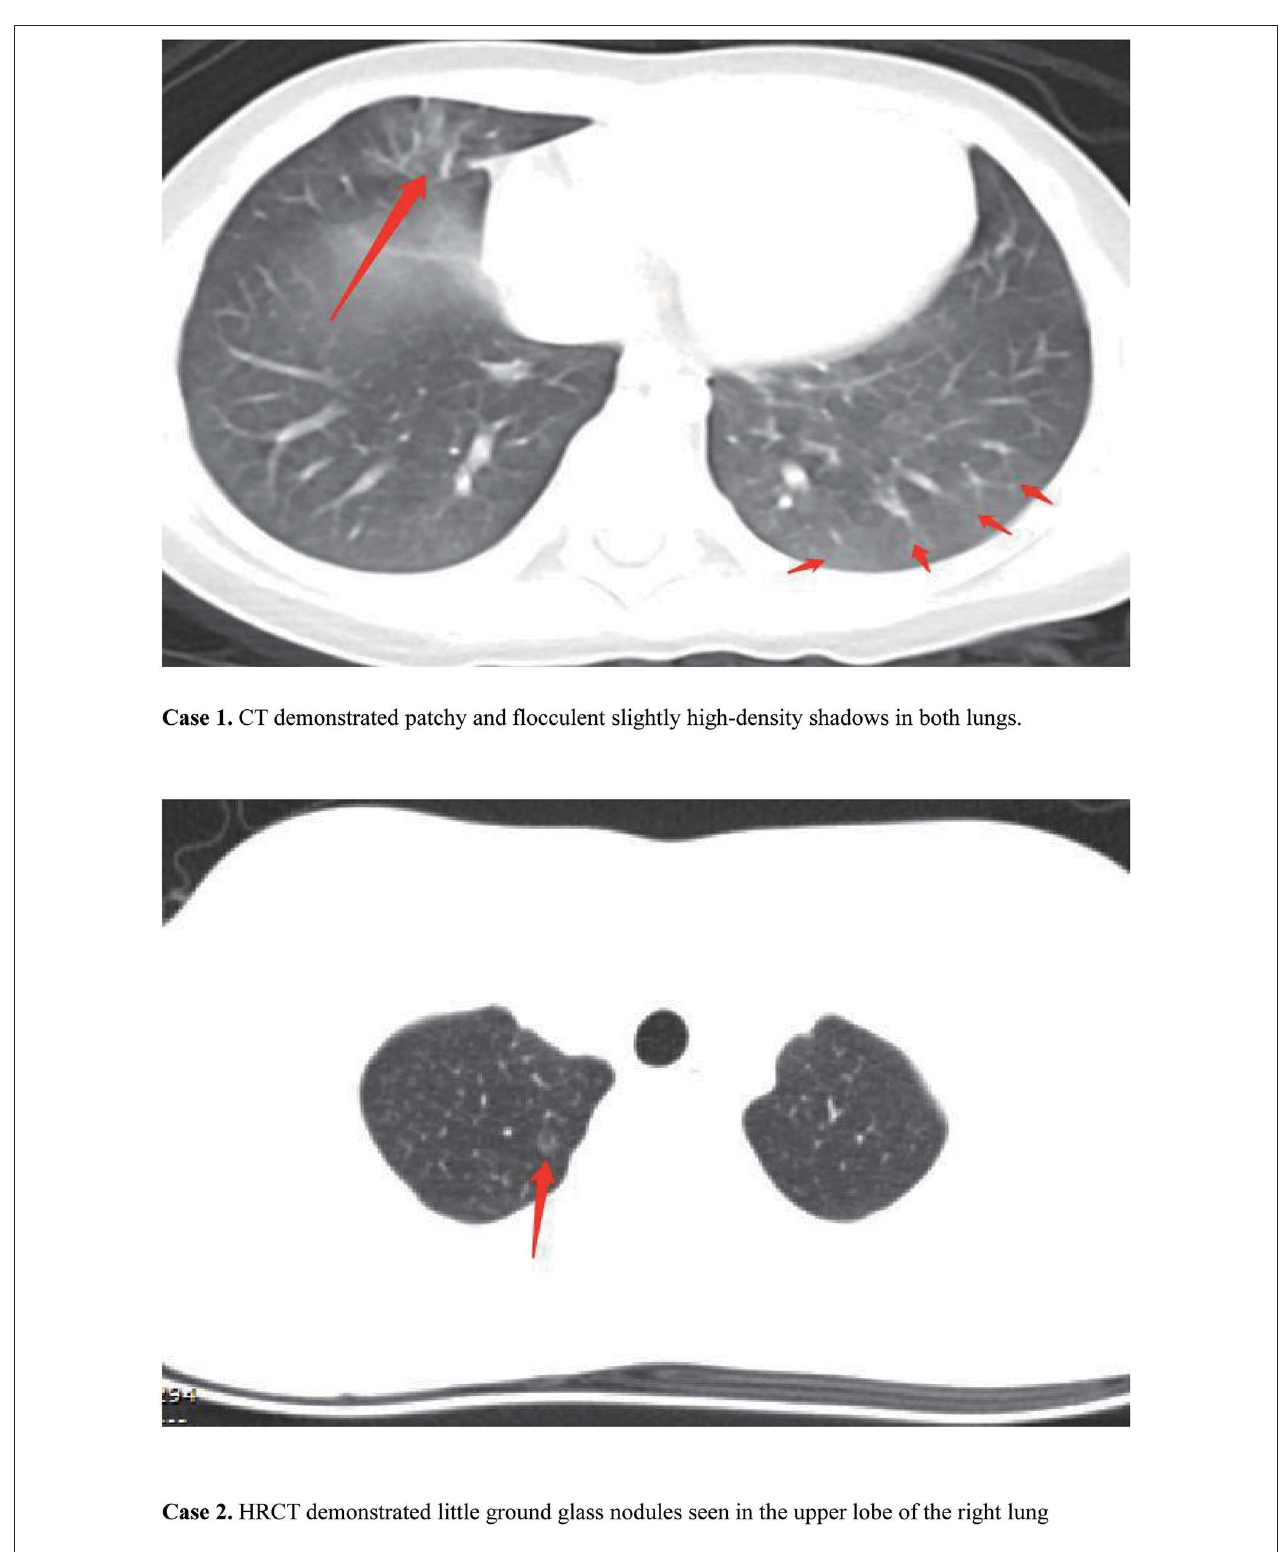
FIGURE 1 | Chest computed tomography (CT) for the two cases. In case 1, CT demonstrated patchy and flocculent slightly high-density shadows in both lungs. In case 2, HRCT demonstrated little ground glass nodules seen in the upper lobe of the right lung.